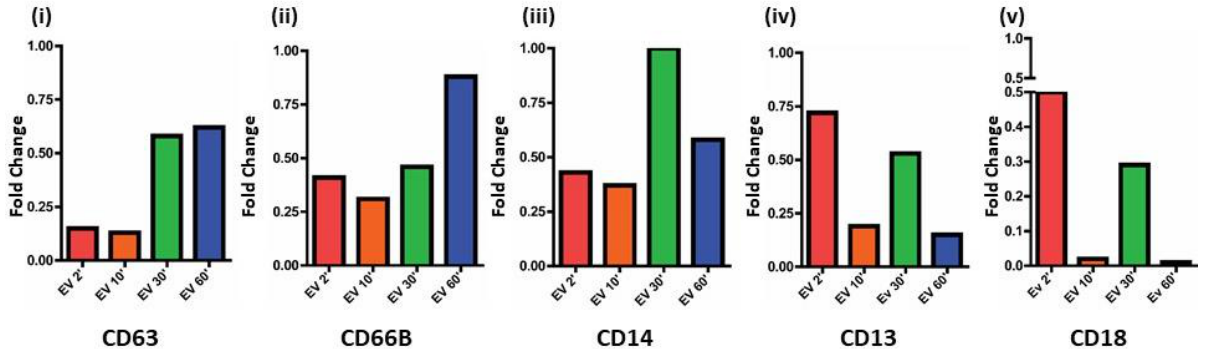
Figure 5. Comparative transcript level comparisons of neutrophil granule mobilization markers; ( i ) azurophil granules (CD63), ( ii ) specific granules (CD66b), and ( iii ) secretory vesicles (CD13, CD14, and CD18). With respect to time point 2′, there is a slight decrease in the levels of CD63, CD66b, CD14, ( iv ) CD13, and ( v ) CD18 followed by which there is an increase in all proteins at time point 30′; this is followed by CD63 and CD66b continuing to increase with time point 60′ while CD14, CD13, and CD18 show a sharp decline in transcript levels at 60′.